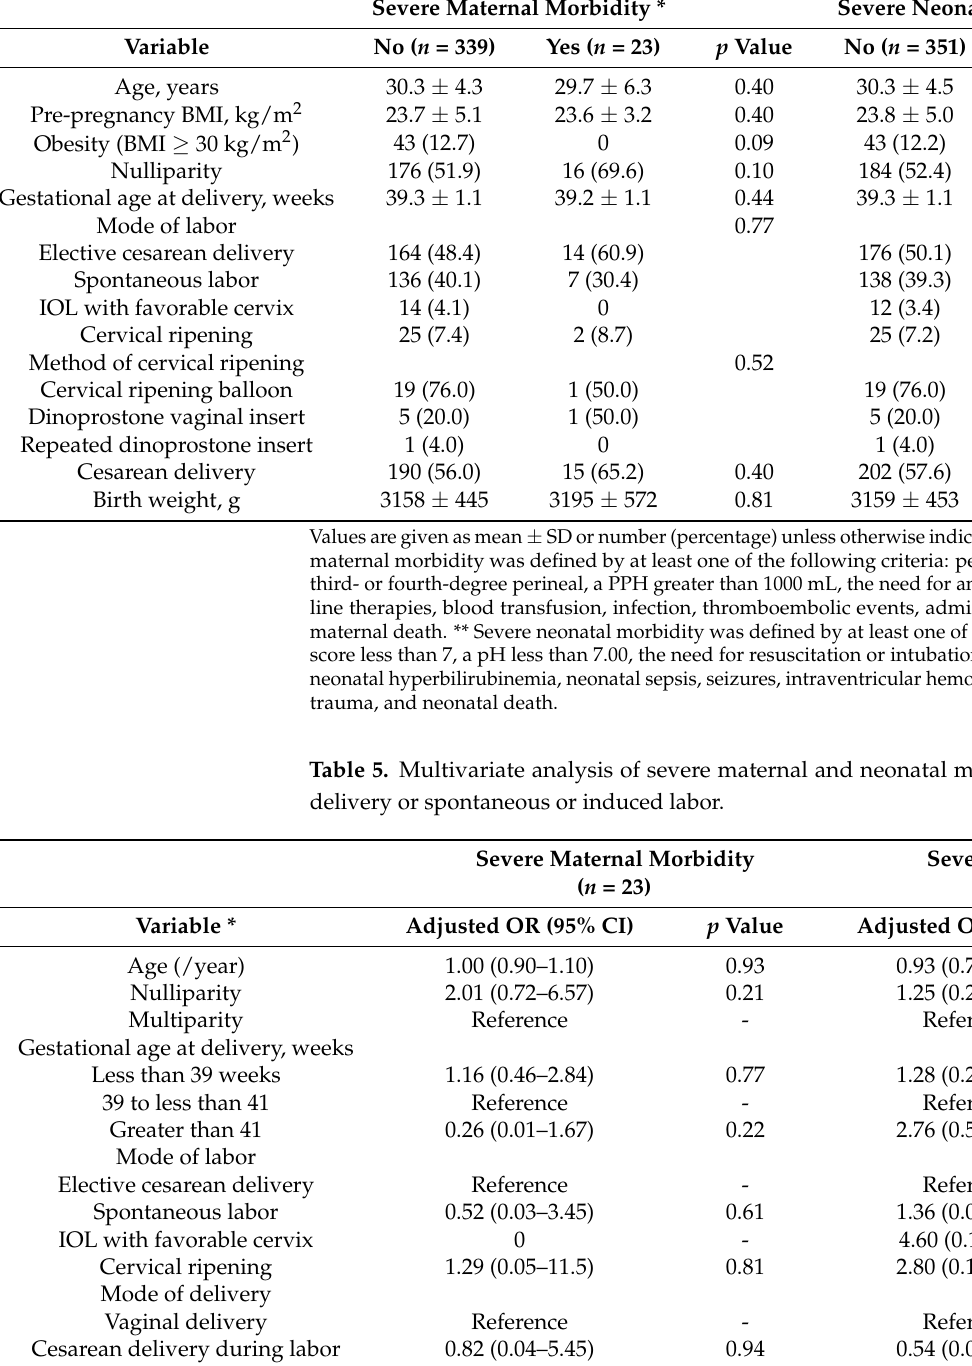
(Table 1). After controlling for risk factors, cervical ripening (compared to elective